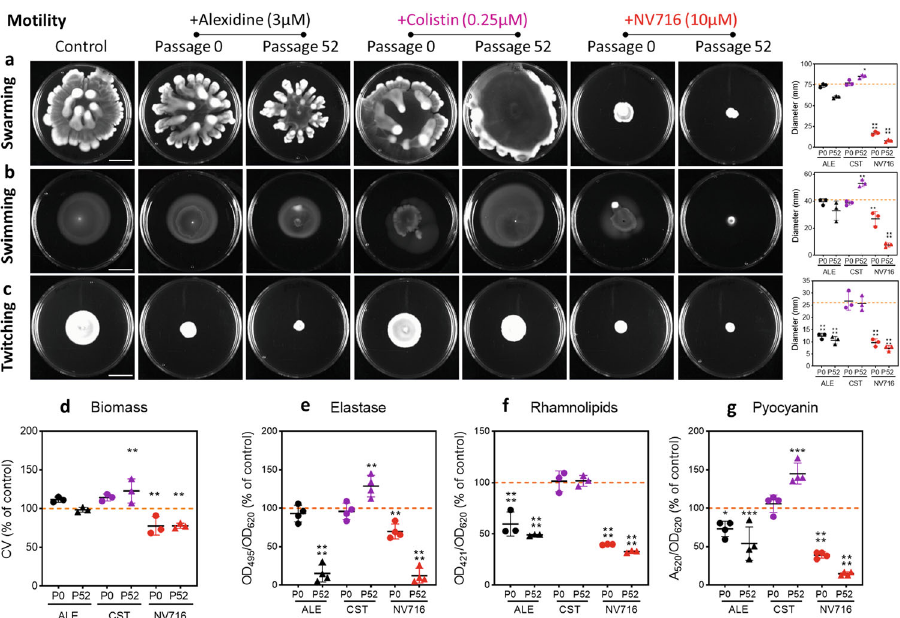
Fig. 7 Assays validating transcriptomic analyses, performed for the parental strain or the fi nal isolate (passage 52) exposed to each potentiator at ½ MIC. Motility assays ( a swarming; b swimming; c twitching); scale bar: 2 cm; bio fi lm formation assessed by biomass quanti fi cation ( d ) and virulence factors secretion ( e – g ). In these panels, all data are expressed in percentage of the untreated control. Data are means of triplicates from 3 to 4 experiments. Statistical analysis: one-way ANOVA with Dunnett ’ s post-hoc test (* p < 0.05; ** p < 0.01; *** p < 0.001; **** p <